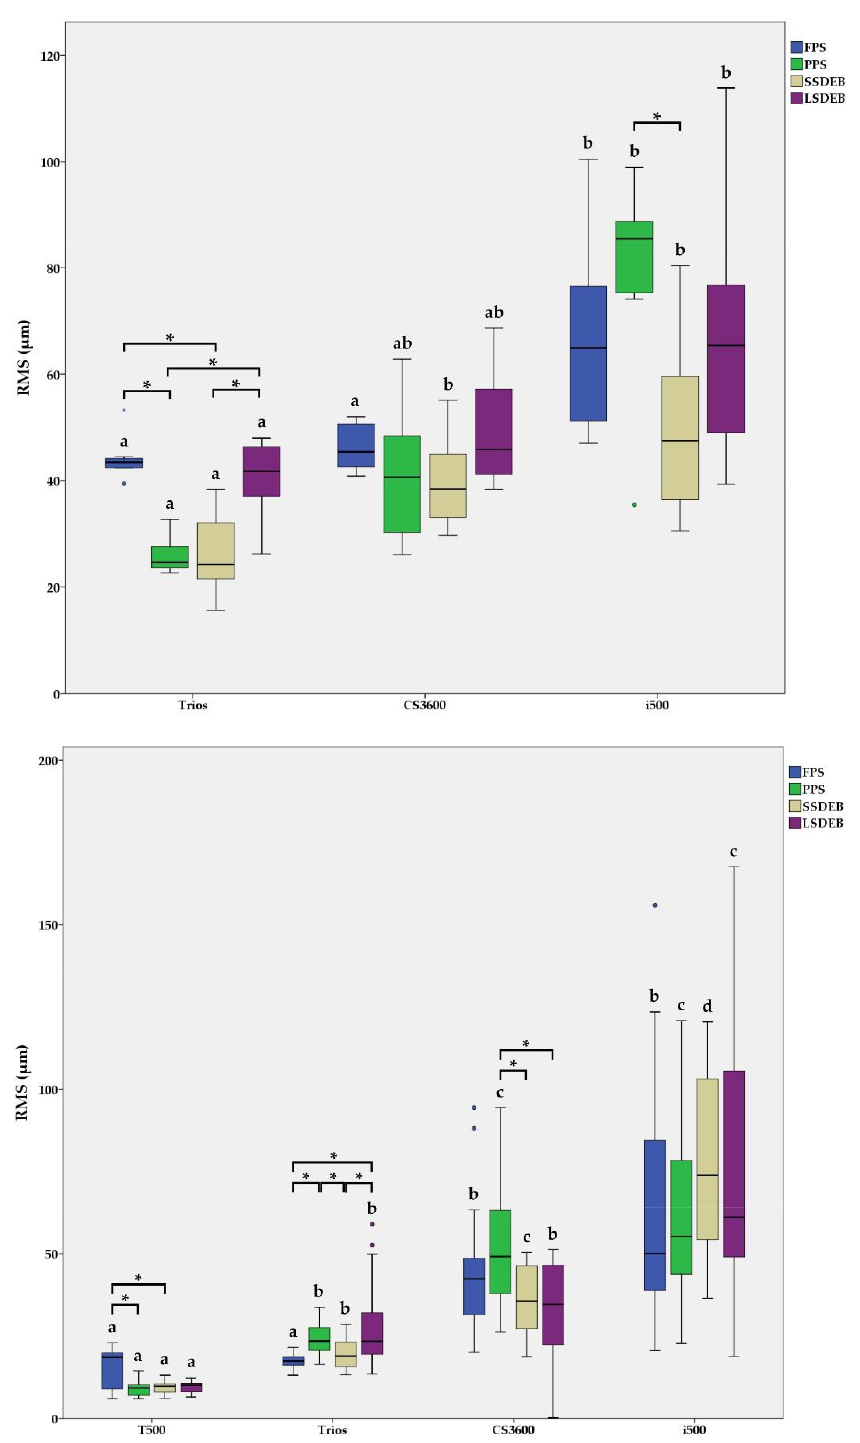
Figure 6. Box plot demonstrating Trueness (upper) and Precision (lower) of the four experimental groups. The amount of deviation is represented as the root mean square (RMS). The X -axis refers to the various scanner utilized. FPS: Full Posterior Support, PPS: Partial Posterior Support, SSDEB: Short Span Distal Extension Base, LSDEB: Long Span Distal Extension Base. The different small letter demonstrates significant differences among the scanners in the identical edentulous conditions. Asterisks indicate a statistically significant difference in pairwise comparison between edentulous conditions on identical scanner group.